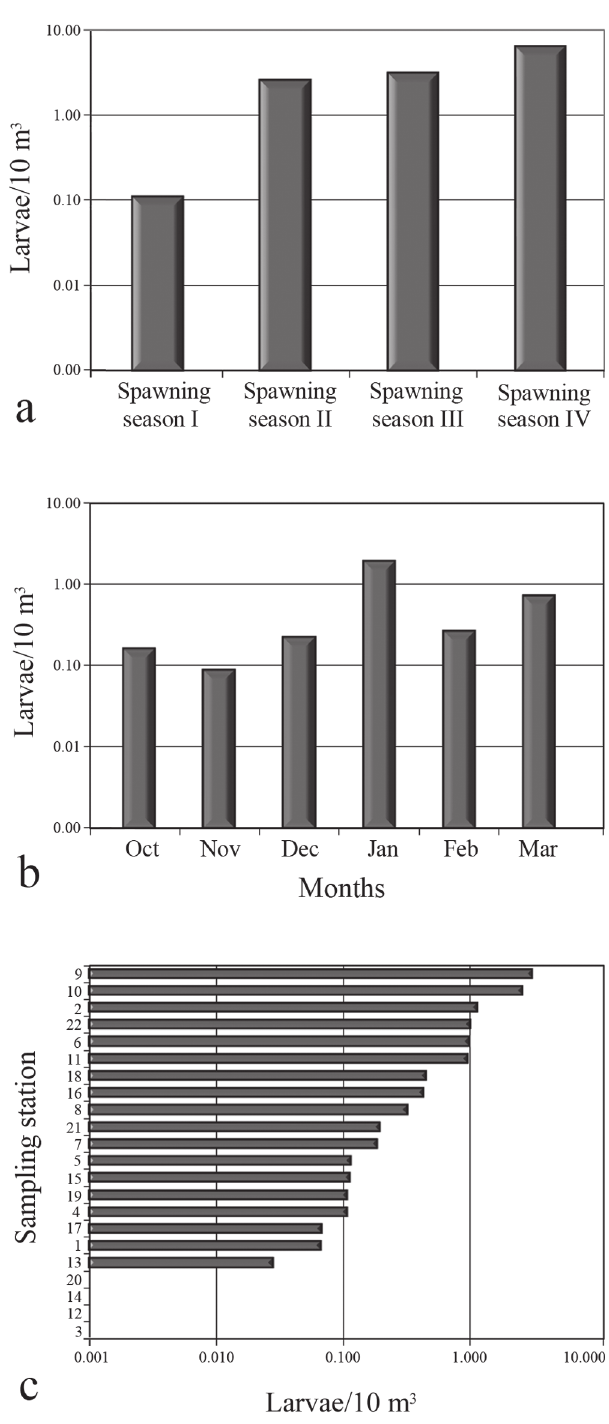
Fig. 2. Average abundance of R . quelen larvae by spawning period ( a ), month ( b ), and sampling station ( c ).